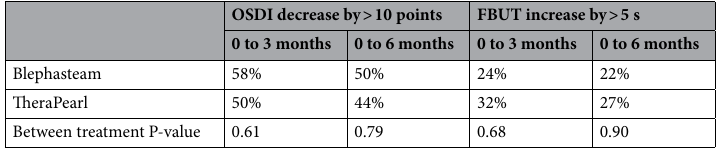
Table 5. Minimal clinically important difference. OSDI ocular surface disease index, FBUT fluorescein breakup